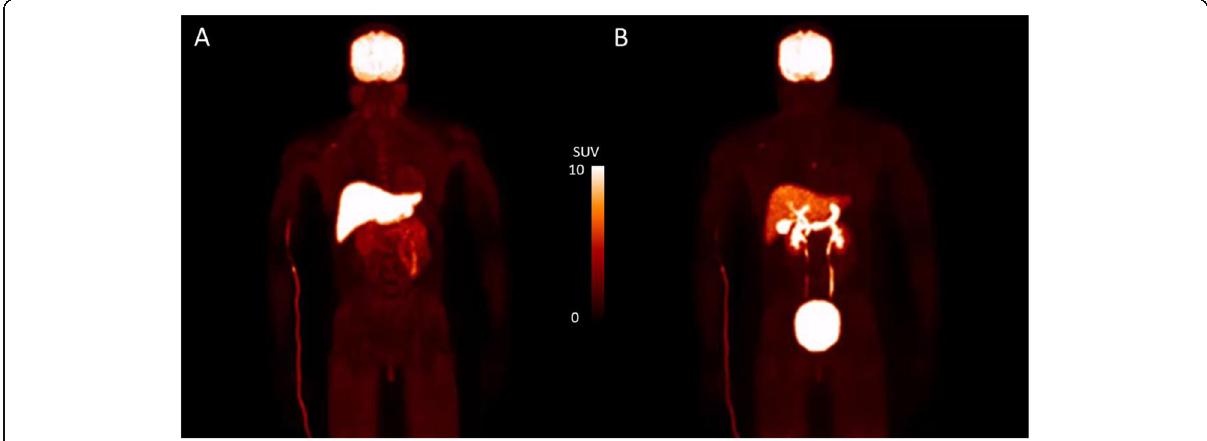
Fig. 1 Representative maximum intensity projection images of 11 C-UCB-J: a 2 – 10 min, b 30 – 60 min. SUV scale, 0 –